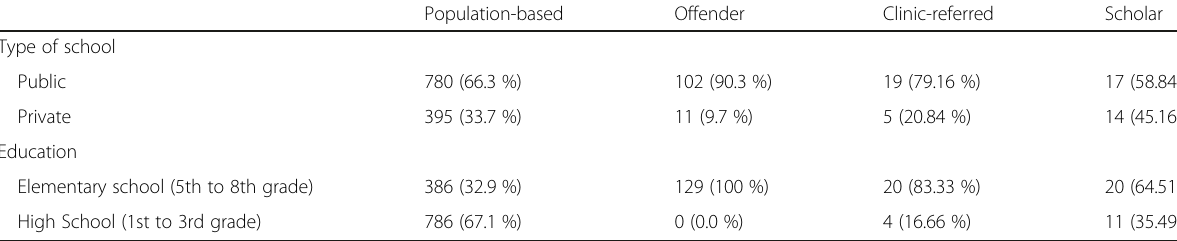
Table 1 Demographic information on the sample groups